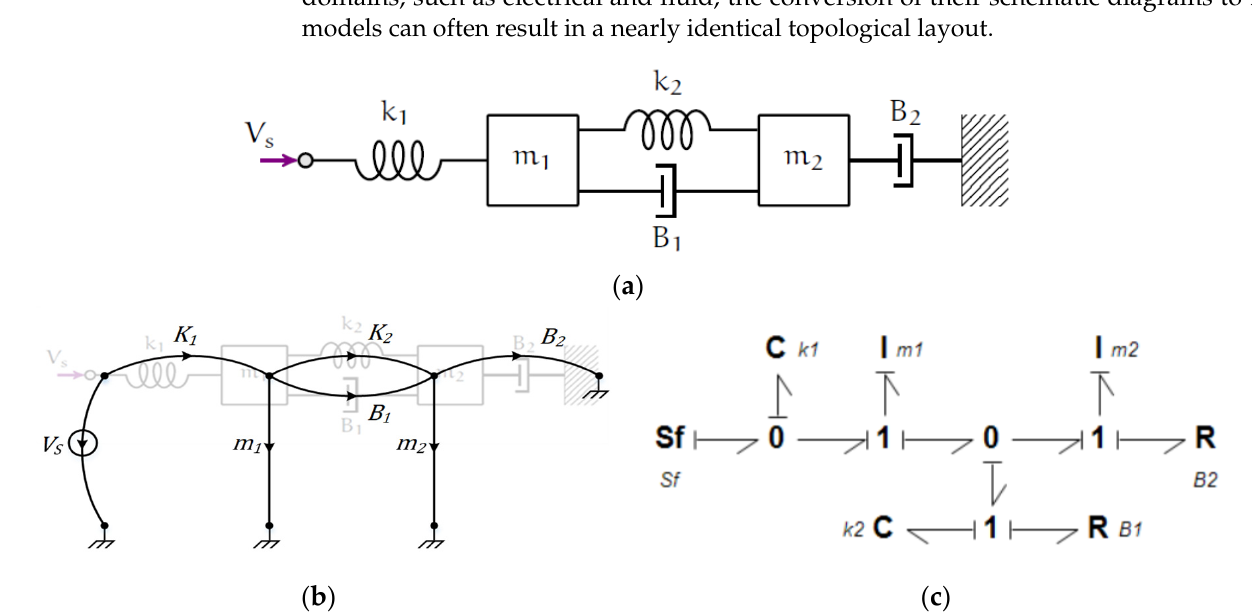
Figure 1. ( a ) Schematic model of a mass-spring-damper system. ( b ) Equivalent LG model. ( c ) Equivalent BG model.